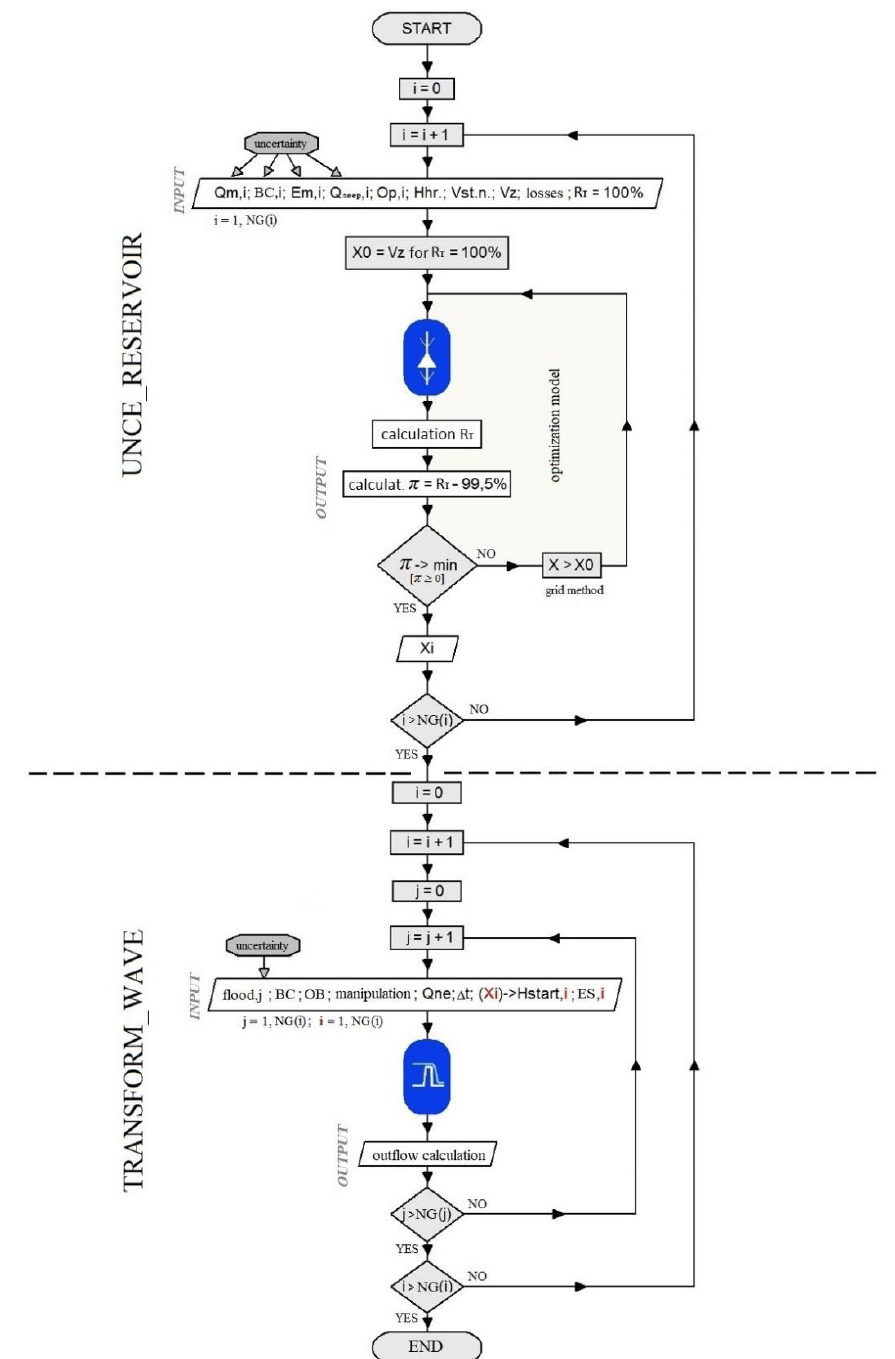
Figure 2. Flow chart of a complex solution for the functional volumes of a reservoir.